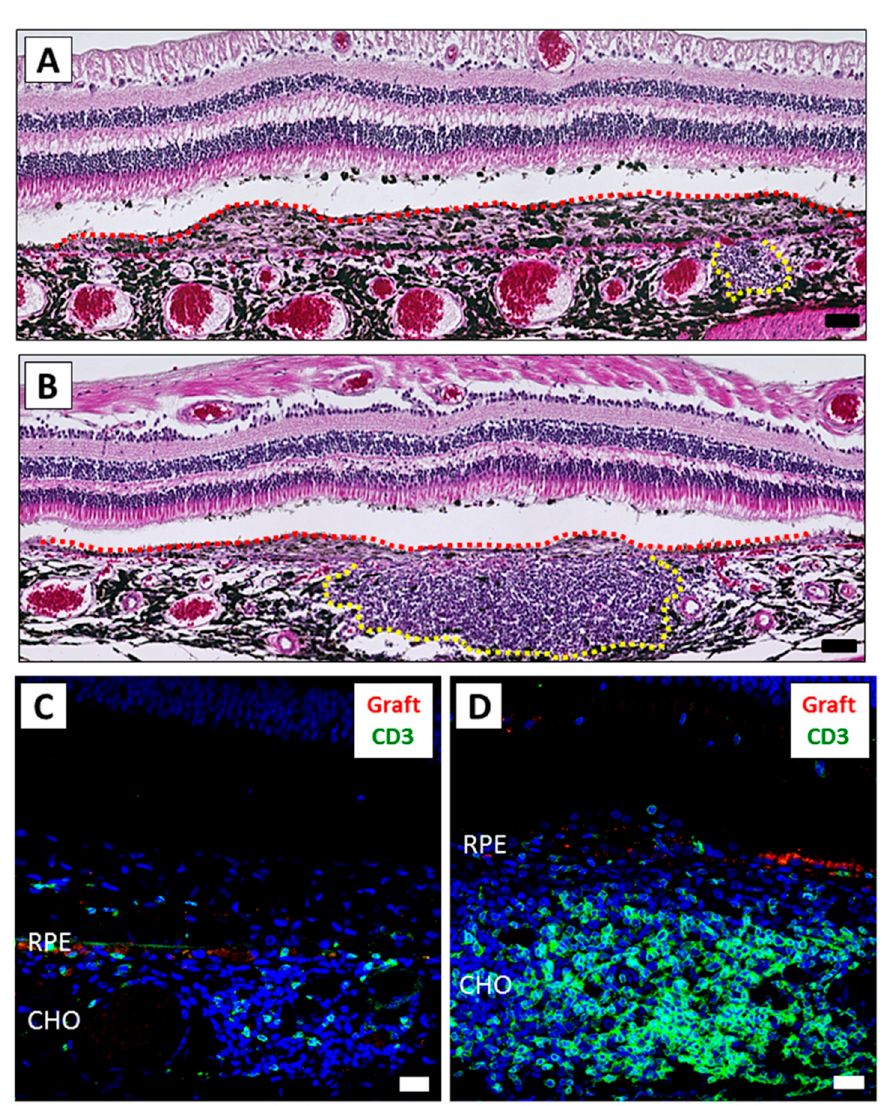
Figure 2. The inflammatory difference between the right and left eyes after iPSC-RPE transplantation. The eyes of monkey HM-1 were histologically examined. ( A , B ) H&E staining of the right ( A ) and left ( B ) eye. Graft cells are indicated by the red dot-line. The mass of inflammatory cells is indicated by the yellow dot-line. The left eye exhibited severe inflammation compared to the right eye. Scale bars: 50 μ m. ( C , D ) IHC of the right ( C ) and left ( D ) eye. A larger amount of CD3 + infiltration (green) was detected in the left eye compared to the right eye. PKH-positive live grafted RPE cells (red) were not detected. Scale bars: 20 μ m. CHO: choroid.